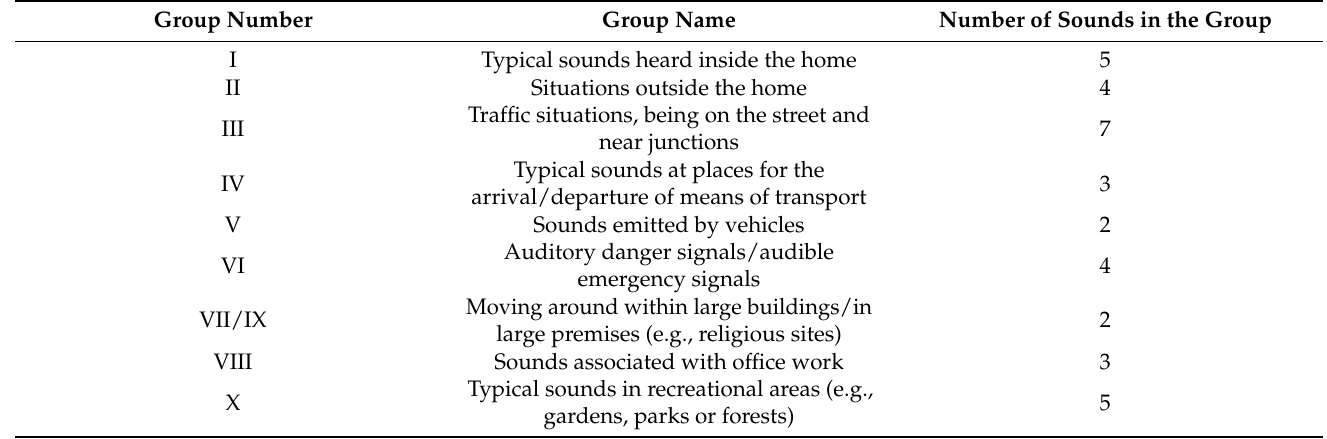
Table 1. Groups of pre-proposed sounds for consultation with people with visual